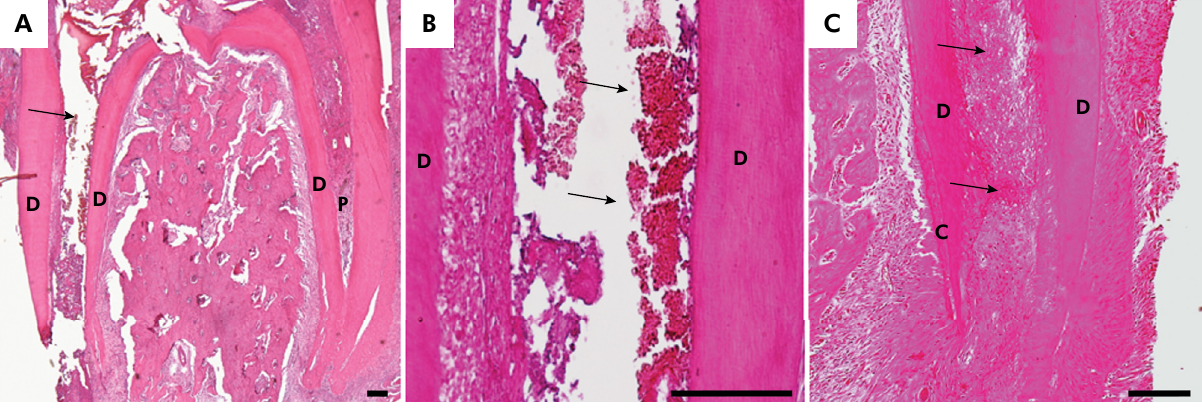
Figure 2. Histological aspects of teeth of animals euthanized immediately after the procedures to confirm the efficacy of protocols. (A) Root canal subjected to pulp removal (arrow) (H&E, 40x magnification). (B) Blood clot induction. Note the presence of blood cells within the canal (arrow) (H&E, 200x magnification). (C) Transplantation of hDPSCs (arrows) (H&E, 100x